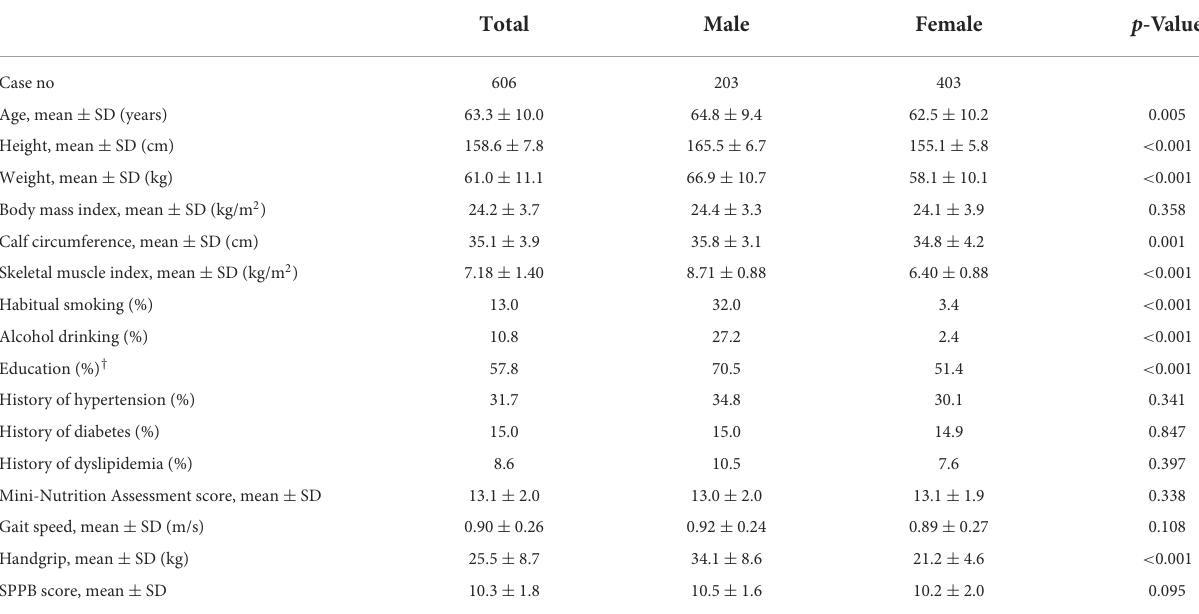
TABLE 1 Demographic characteristics of 606 Taiwanese adults at